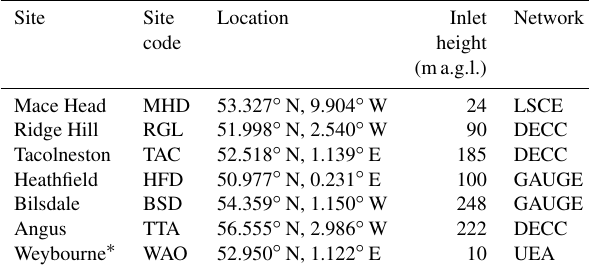
Table 1. Measurement site information. The location of sites is also shown in Fig. 1. ∗ Weybourne data were used for validation of the results only and were not included in the inversions. LSCE – Lab- oratoire des Sciences du Climat et de l’Environnement; DECC – Deriving Emissions related to Climate Change; GAUGE – Green- house gAs Uk and Global Emissions; UEA – University of East Anglia. Site Site Location